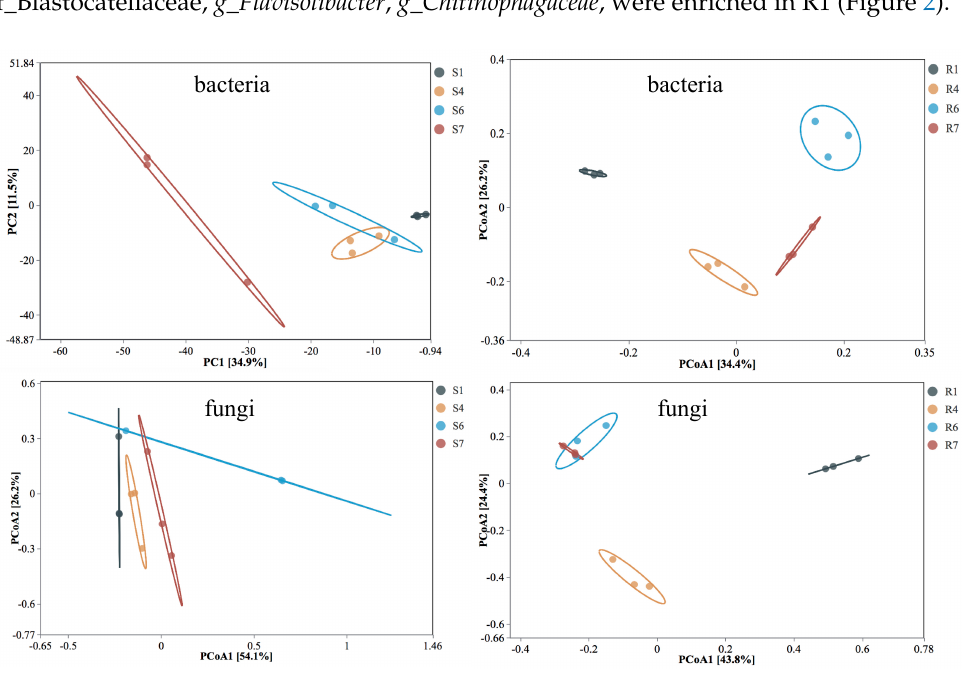
Figure 3. PC and PcoA of the bacterial and fungal communities of different compartments (S, R, and B indicate root endosphere, rhizosphere, and bulk soil, respectively) across the different varieties (1,6 indicate the rot-conducive variety; 4,7 indicate the rot-suppressive variety) and farming modes (1,4 belong to monoculture mode; 6,7 belong to rotation mode).